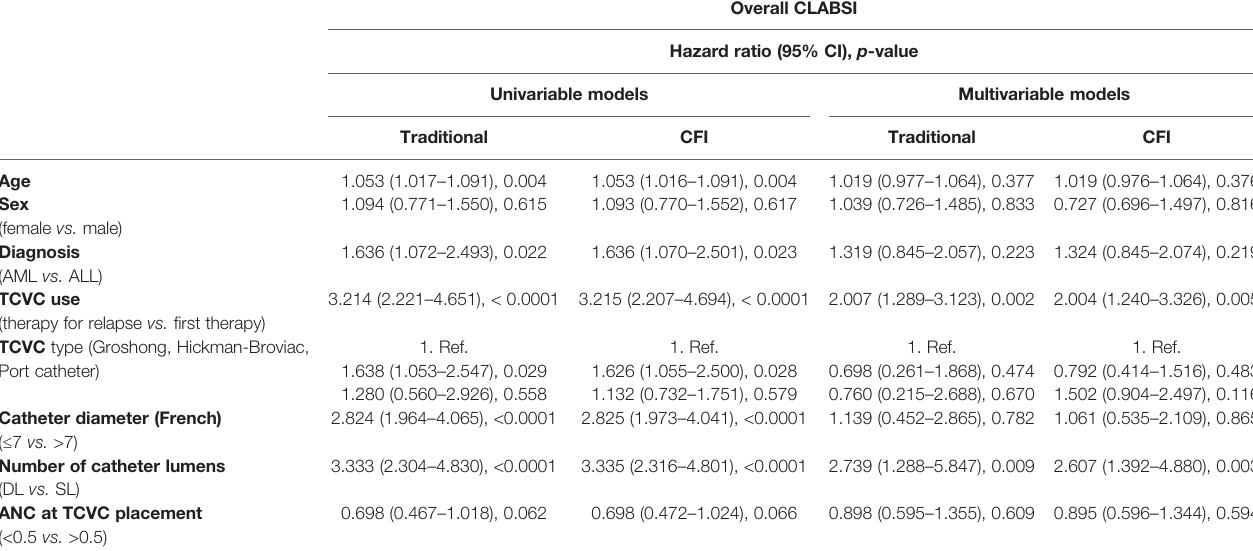
TABLE 3 | Univariable and multivariable regression analysis for secondary